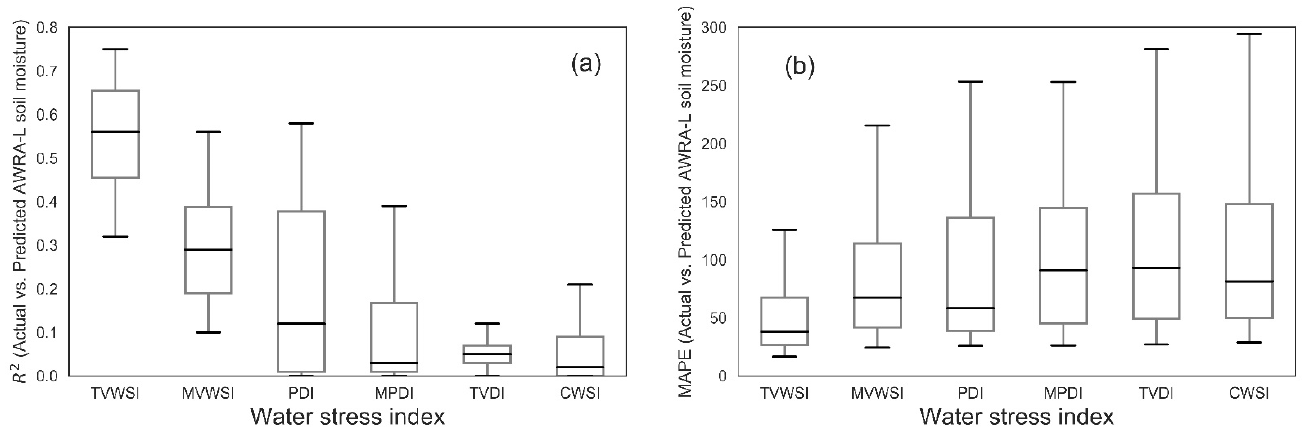
Figure 11. The range of ( a ) R 2 (Actual vs. Predicted AWRA-L soil moisture) and ( b ) Mean Absolute Percentage Error (MAPE) (Actual vs. Predicted AWRA-L soil moisture) obtained across sixty study sampling windows using the first-order polynomial model fitted to AWRA-L soil moisture vs. the indices named along the x-axis.